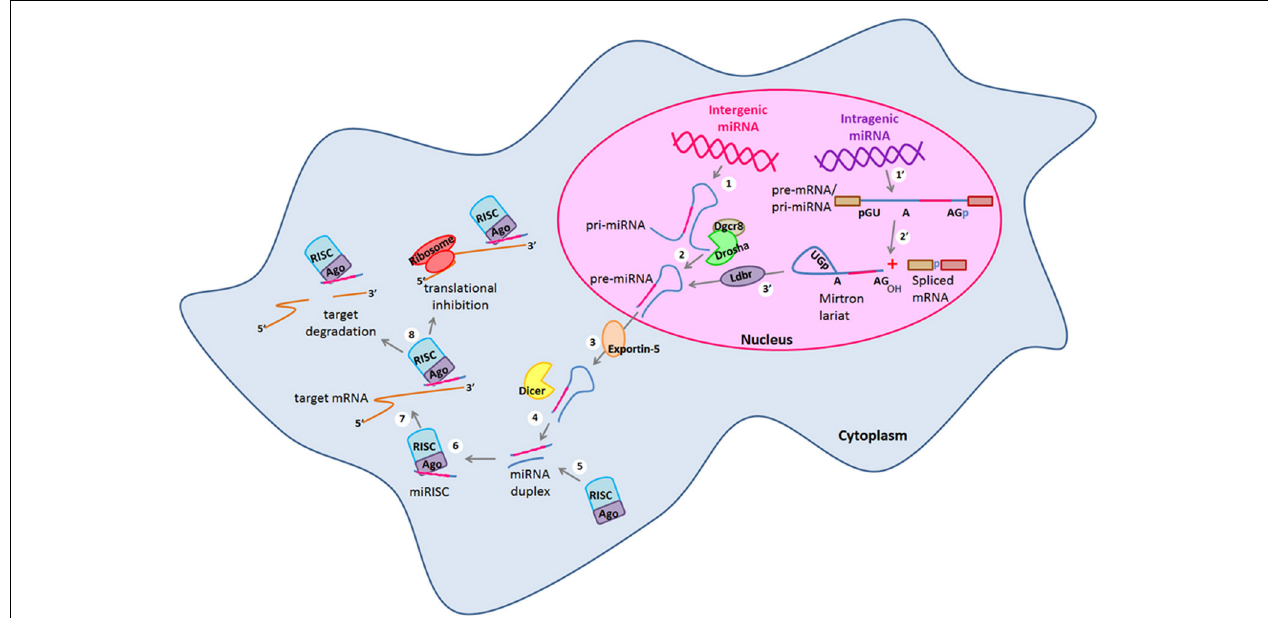
FIGURE 1 | miRNA canonical and non-canonical biogenesis. Biogenesis of intergenic microRNAs (miRNAs) begins with the (1) transcription of miRNA genes by the RNA Polymerase II to generate long transcripts known as primary miRNAs (pri-miRNAs) which are then (2) processed by the microprocessor complex formed by Drosha and Dgcr8 in the nucleus and pre-cursor miRNAs (pre-miRNAs) are generated. On the other hand, intragenic miRNAs are also (1 (cid:2) ) transcribed as part of the pre-mRNAs of their host protein coding genes which are then (2 (cid:2) ) spliced by the alternative splicing machinery giving rise to the spliced mRNA and to a mirtron lariat that contains the future mature miRNA. After that, mirtron lariat is (3 (cid:2) ) debranched by the Ldbr enzyme and finally a pre-miRNA is generated. At this point, both